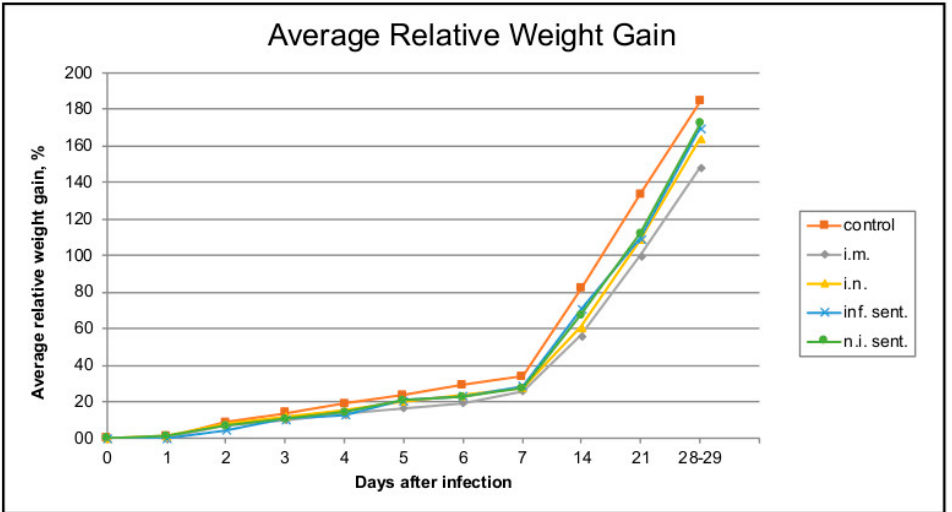
Figure 2. Average relative daily weight gain. Piglets were weighed on study days 0–7, 14, 21 and 28 / 29. The initial body weight was set as 100% value and relative weight gain was calculated for every individual at the indicated time-points. The mean value was calculated for every trial group. Infected groups show a slightly reduced weight gain compared to the negative control group after 7 days post- infection. However, the absolute differences between the groups were not significant.